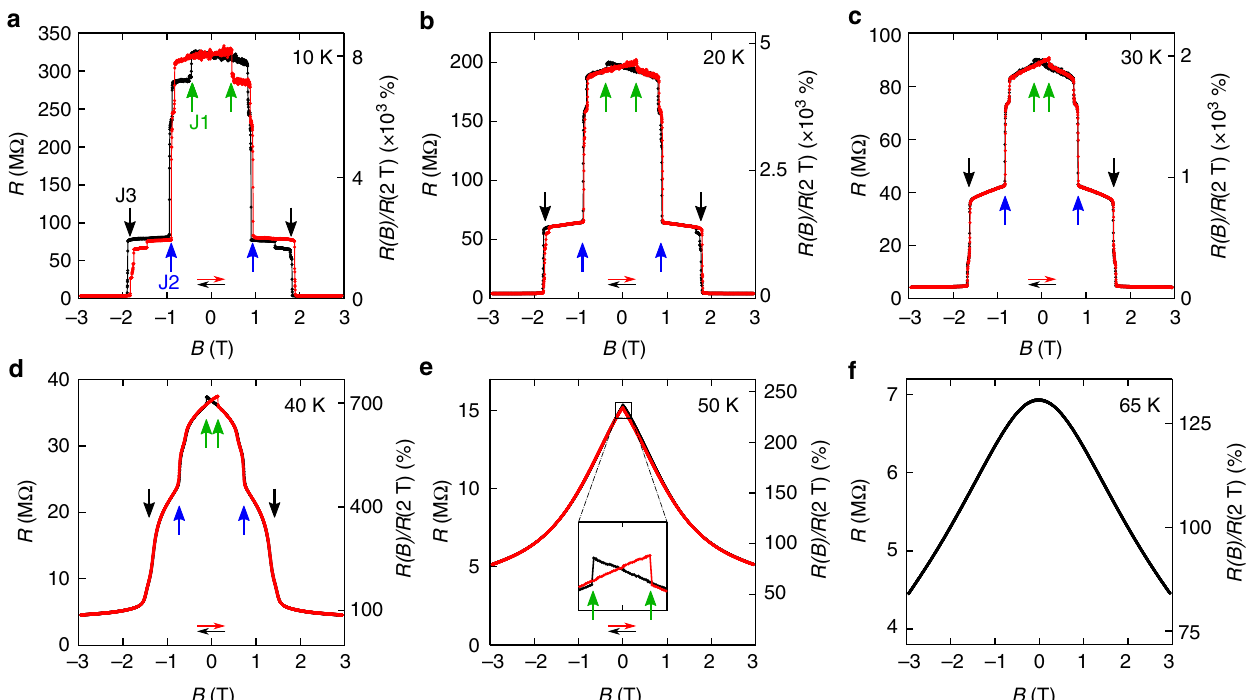
Fig. 3 Large tunneling magnetoresistance in vertical junctions. a – f Tunneling resistance (left axis) and resistance ratio R ( B )/ R (2 T) (right axis) of the device shown in Fig. 1d, measured at the temperature indicated in each panel (with V = 0.5 V and B applied perpendicular to the CrI 3 layers). The red and black dots correspond to data measured upon sweeping the fi eld in opposite directions as indicated by the horizontal arrows of the corresponding color. The resistance ratio increases upon lowering temperature and reaches 8,000% at 10 K. The arrows of different color point to the magnetoresistance jumps that are seen in all devices, irrespective of the thickness of the CrI 3 crystal. Jump J1 is always accompanied by hysteresis; at low temperature, jumps J2 and J3 occur in all devices at the same value of the applied magnetic fi eld, irrespective of sweeping direction. All jumps shift to lower fi eld values upon increasing temperature, and disappear above 50 K